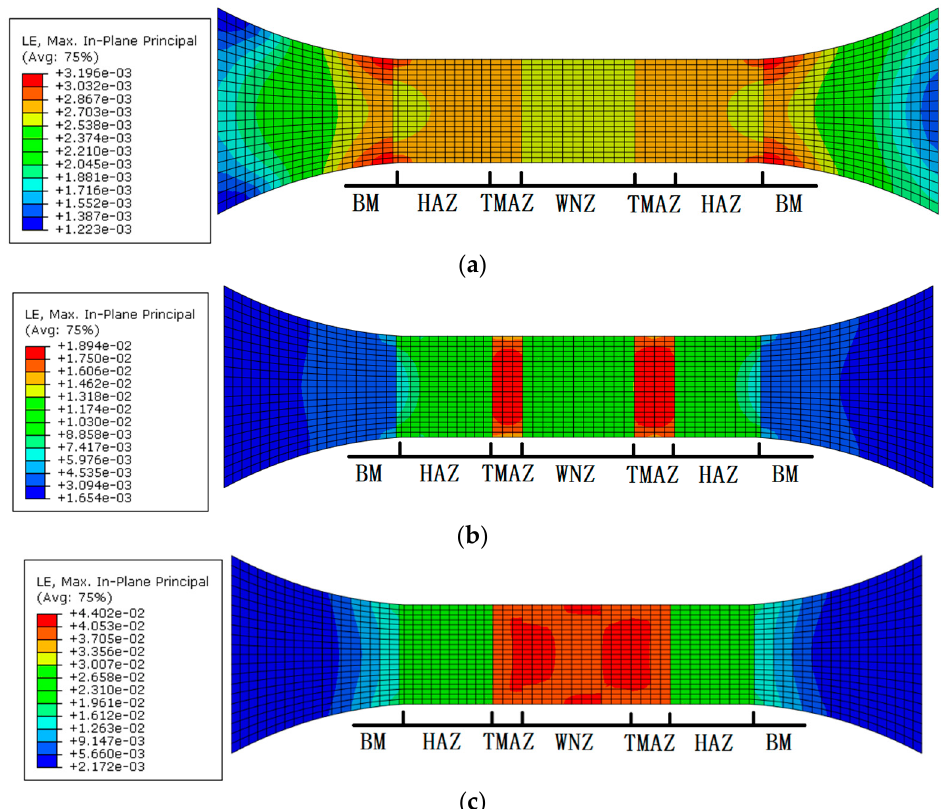
Figure 8. Principal strain distribution of the FSW joint under loading stress of ( a ) 170 MPa, ( b ) 230 MPa, and ( c ) 300 MPa.